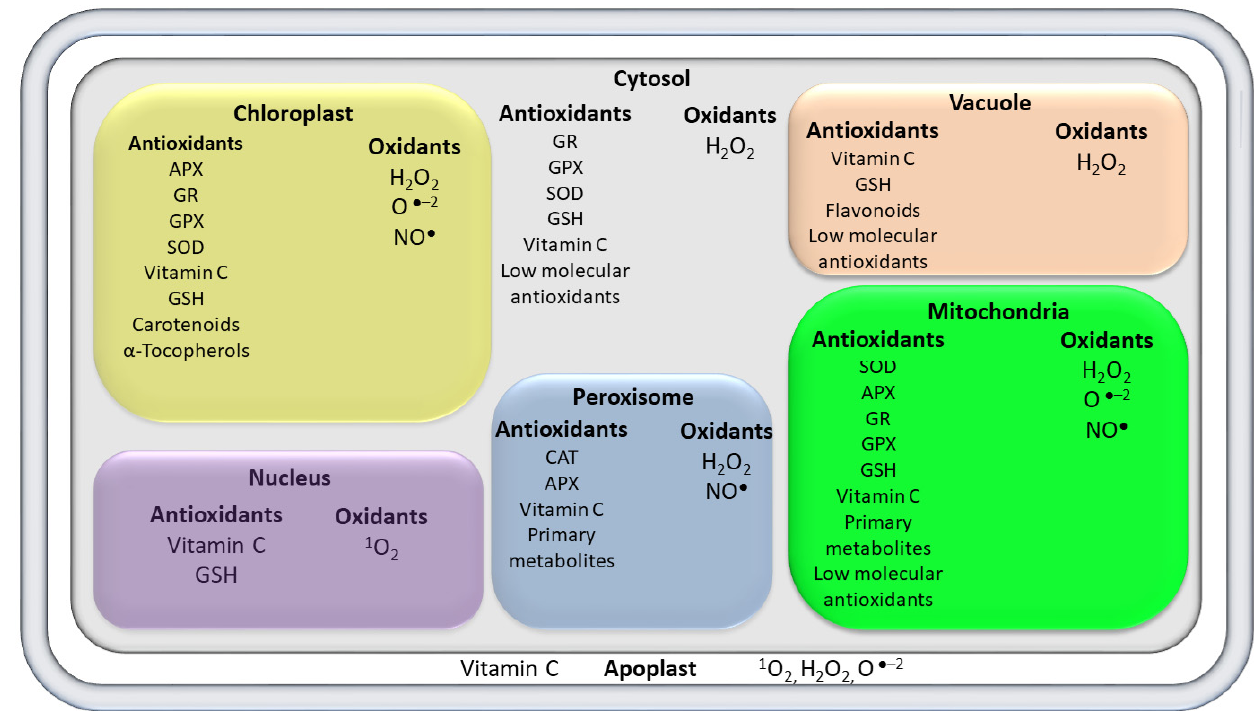
Figure 2. Distributions of antioxidants and oxidants in different subcellular organelles of the plant cells. APX, ascorbate peroxidase; GR, glutathione reductase; GPX, glutathione peroxidase; SOD, superoxide dismutase; CAT, catalase; GSH, glutathione; NO, nitric acid; 1 O 2 , singlet oxygen; O •–2 , superoxide; H 2 O 2 , hydrogen peroxide. Table 1. Chemical reaction of enzymatic and metabolic antioxidants with reactive oxygen species (ROS). Enzymatic Scavenging Metabolic ROS Reacts with System Antioxidants Stress Tolerance